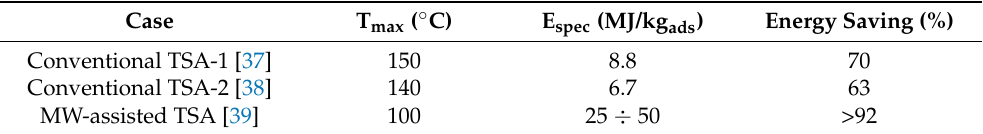
Table 8. Comparison Table 1—energetic features.